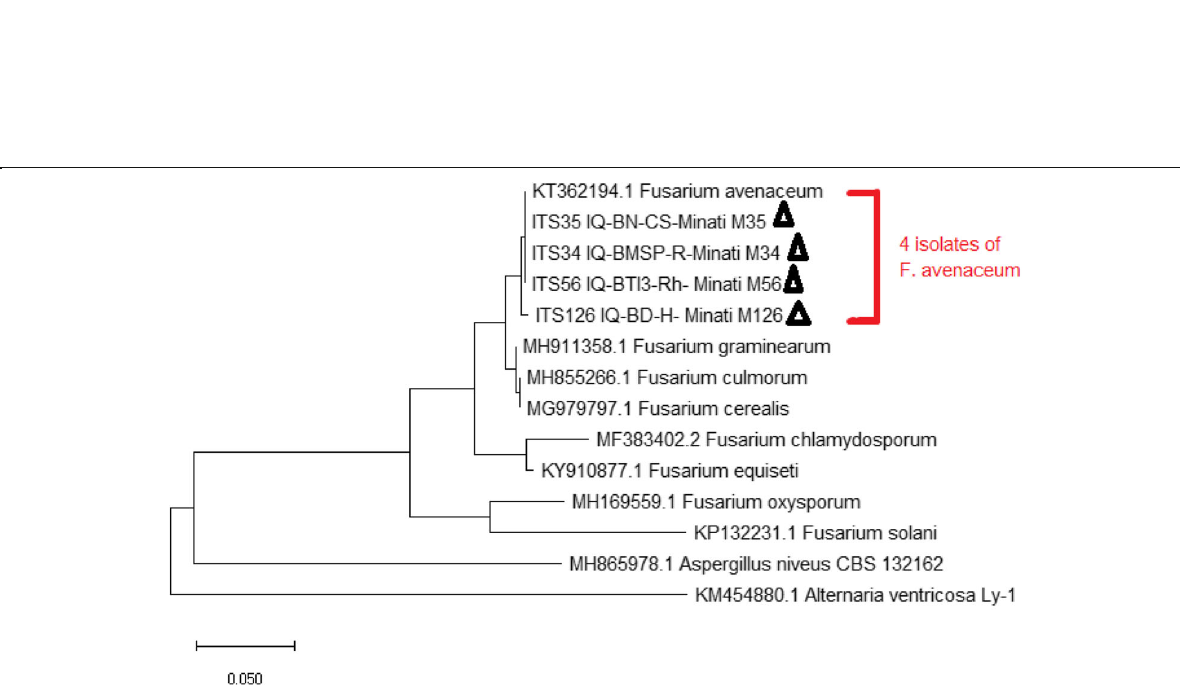
Fig. 6 Phylogenetic tree generated with the ITS-rDNA sequences of the Fusarium graminearum (19), as inferred from the maximum likelihood (ML) analyses (determined by black triangles) and related species retrieved from GenBank. ITS sequences of Aspergillus niveus (MH865978) and Alternaria ventricosa (KM454880) were used as the out-group species